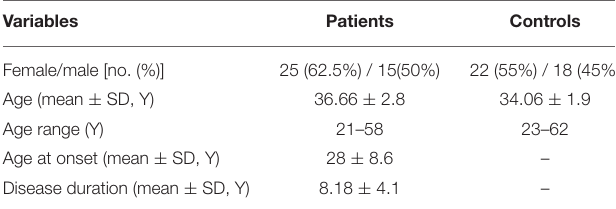
TABLE 2 | Data of study